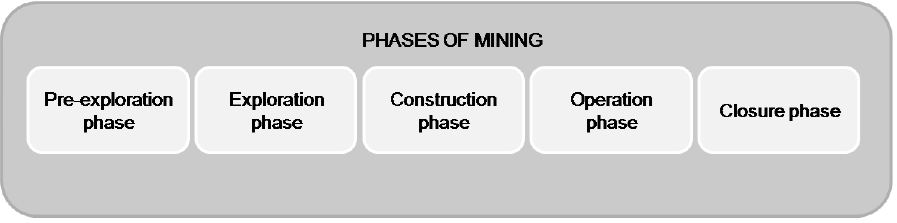
FIGURE 2: Phases of mining Source: Own